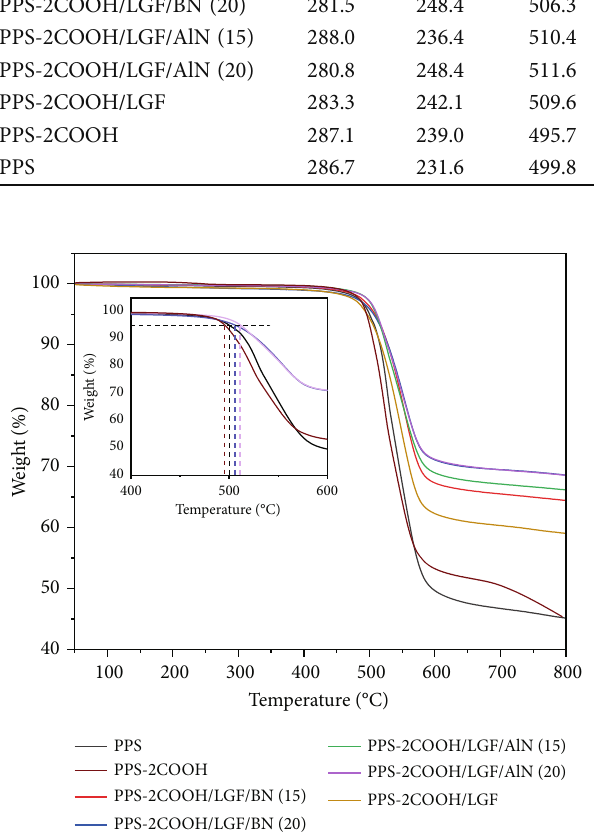
Figure 7: TGA curves of PPS, PPS-2COOH, PPS-2COOH/LGF/ BN, and PPS-2COOH/LGF/AlN in a nitrogen atmosphere.